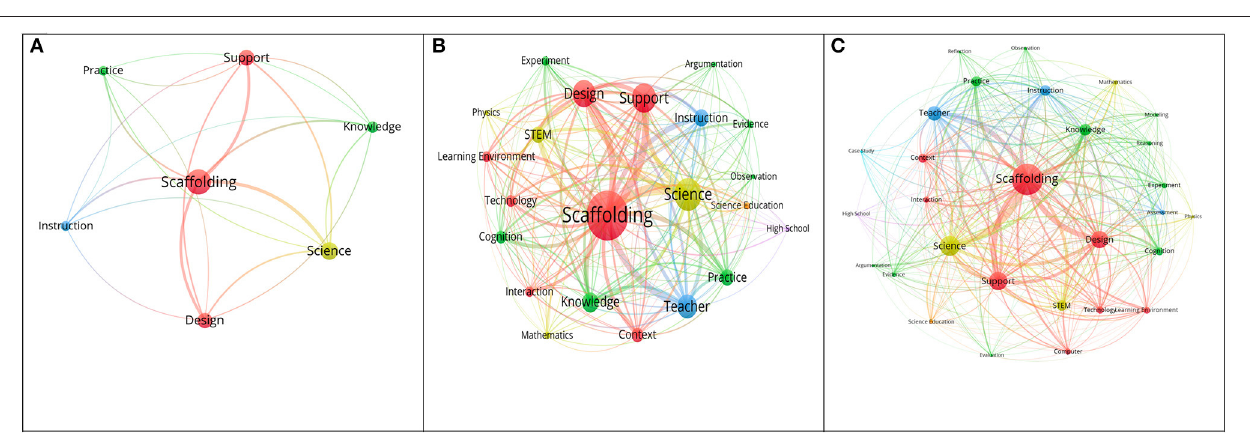
FIGURE 6 | (A) The co-occurred network of scaffolding research (2005–2009, keywords = 7). (B) The co-occurred network of scaffolding research (2010–2014, keywords = 22). (C) The co-occurred network of scaffolding research (2015–2019, keywords = 29).